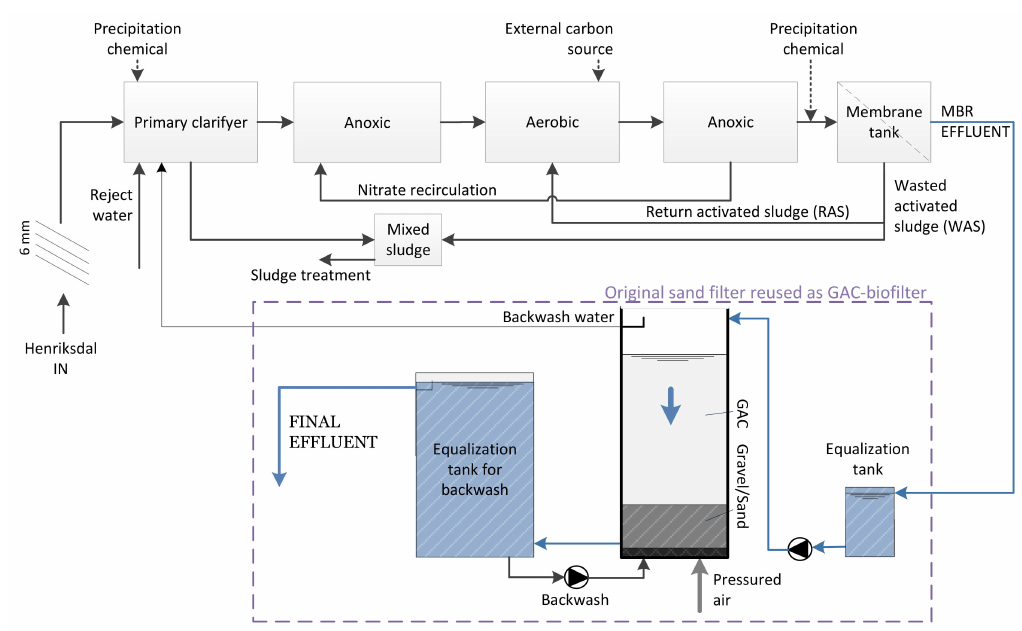
Figure 1. Schematic illustration of the pilot setup including a membrane bioreactor MBR and granulated active carbon (GAC)-biofilter for removal of